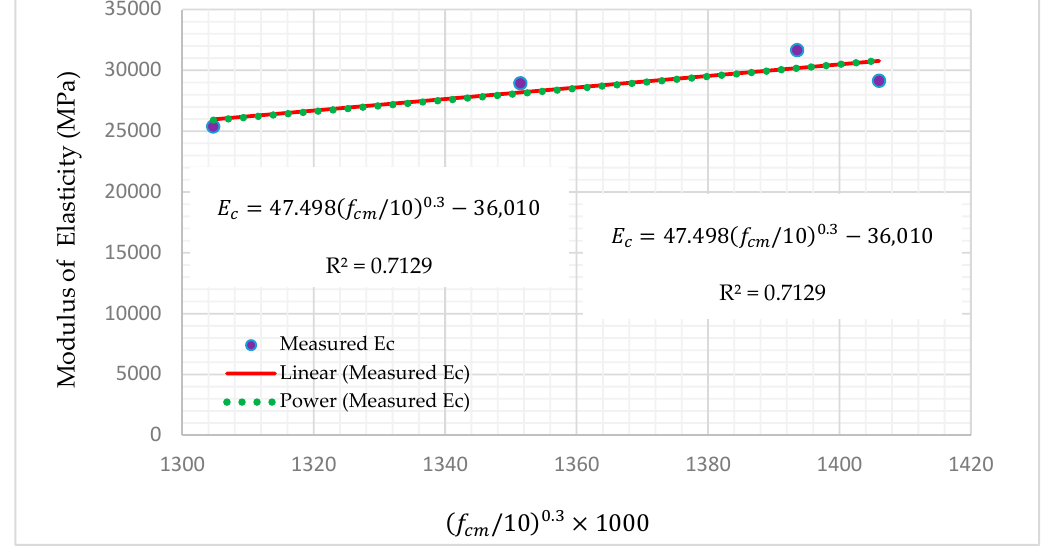
Figure 11. The relationships between E c and f cc in the form of Eurocode equations.